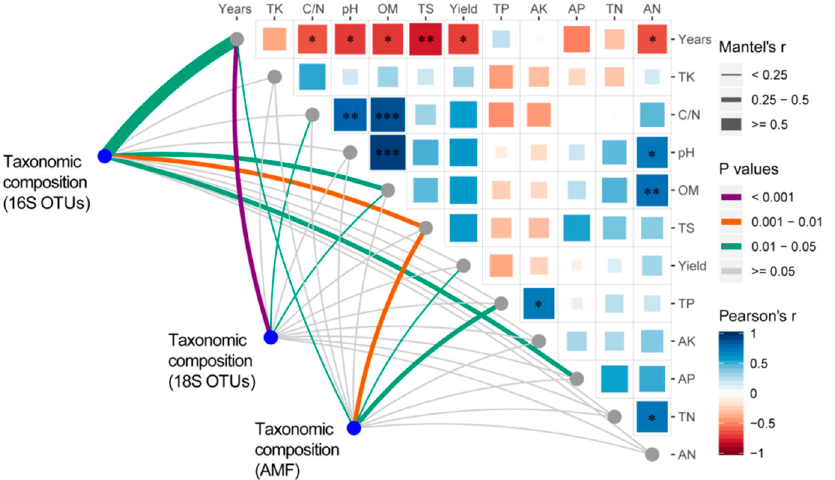
Figure 5. The relationship between environmental variables and soil microbial community composition. Pairwise comparison of ecological factors and color gradients representing Pearson's correlation coefficient. Taxonomic groups were related to each ecological aspect using the Mantel test. Edge width corresponds to the Mantel’s r statistic for the corresponding distance correlations, and edge color denotes the statistical significance based on 999 permutations. TN, total nitrogen; TK, total potassium; TP, total phosphorus; TS, total sulfur; OM, organic matter; AN, available nitrogen; AK, available potassium; AP, available phosphorus; C/N, carbon–nitrogen ratio. * p < 0.05. ** p < 0.01. *** p < 0.001